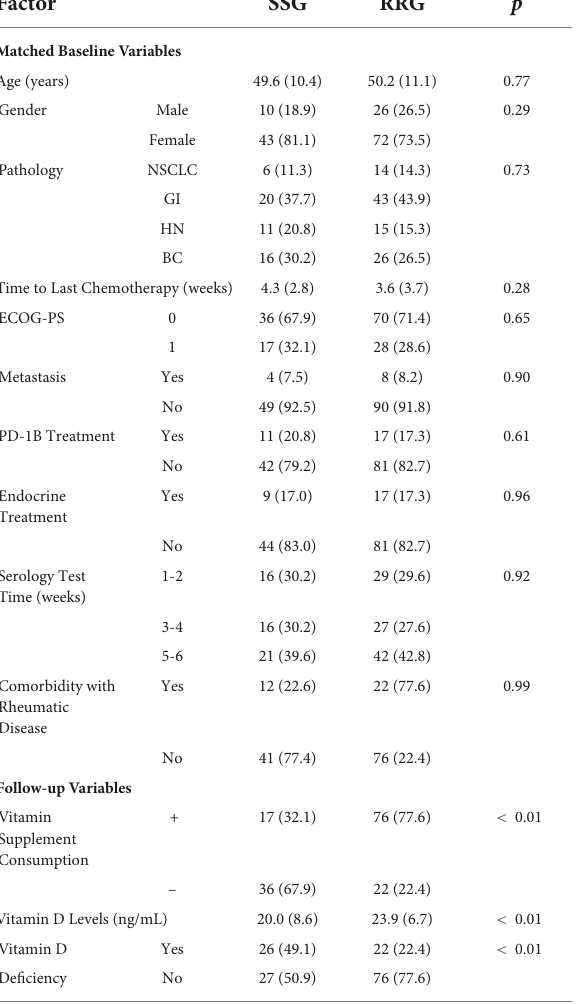
TABLE 4 Propensity score-matched comparison between SSG and RRG-B. Factor